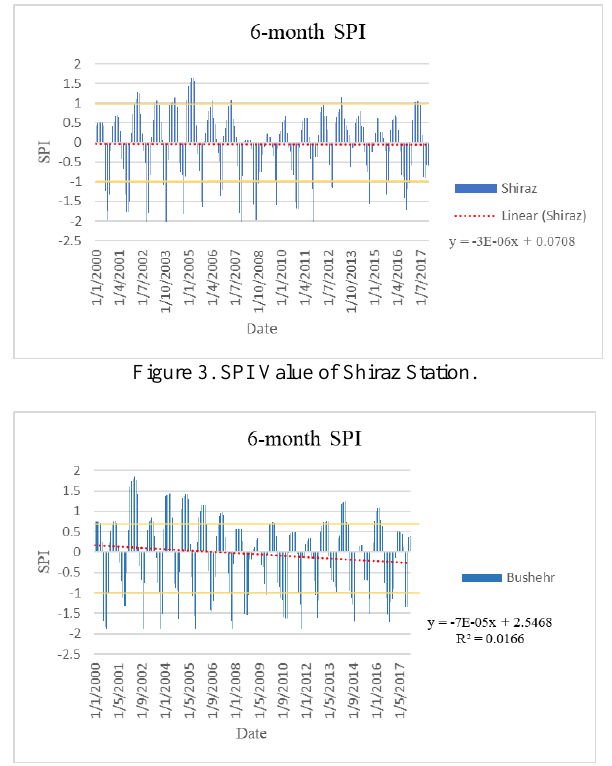
Figure 4. SPI Value of Bushehr Station.